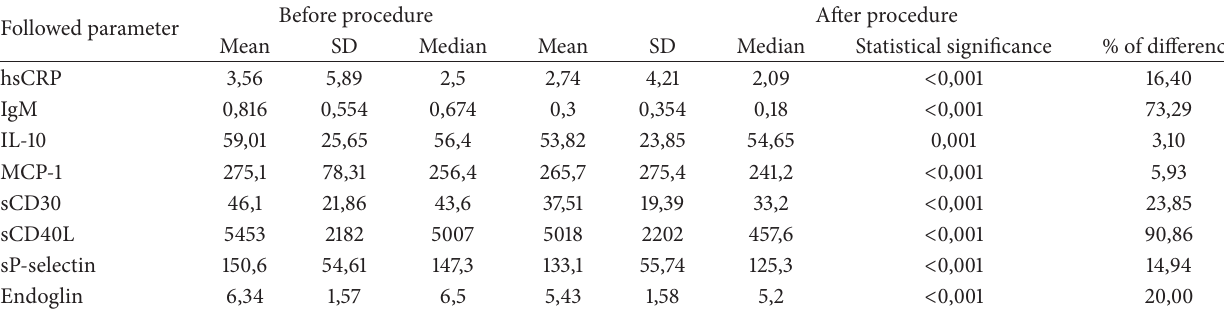
Table 5: Specific haematological